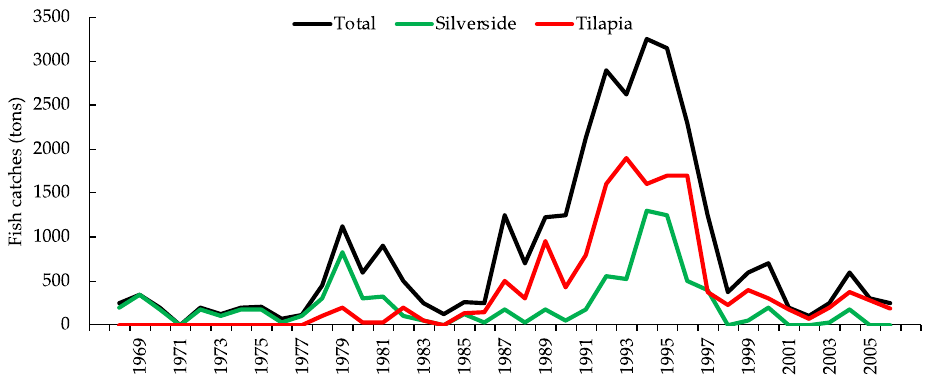
Figure 2. Annual catch volumes of fishery products in Lake Cuitzeo. (Modified from [3]).